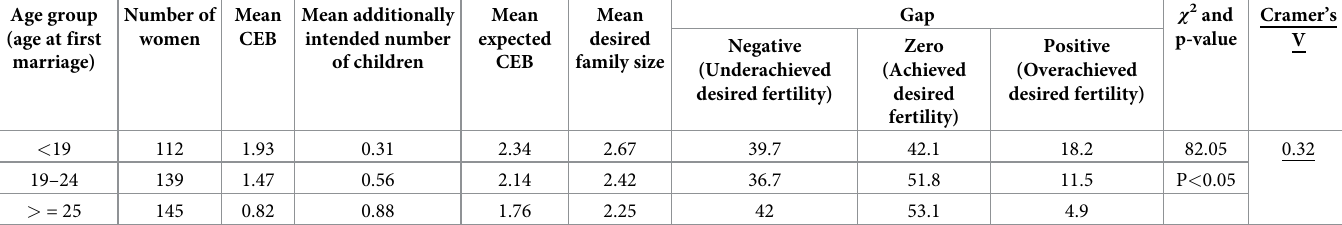
Table 2. Mean number of children ever born (CEB), mean expected CEB, mean desired family size and the gap between mean CEB and mean expected CEB by age at first